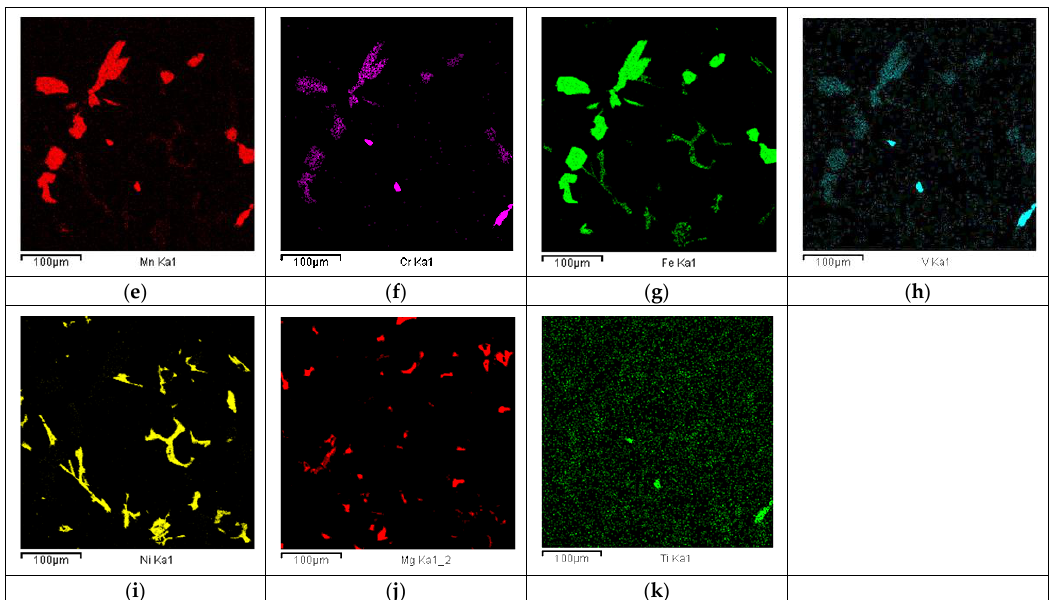
Figure 4. SEM micrograph, CAMEO image ( a ) and mapping of elemental distribution ( b – k ) of hypereutectic aluminum-silicon alloy.